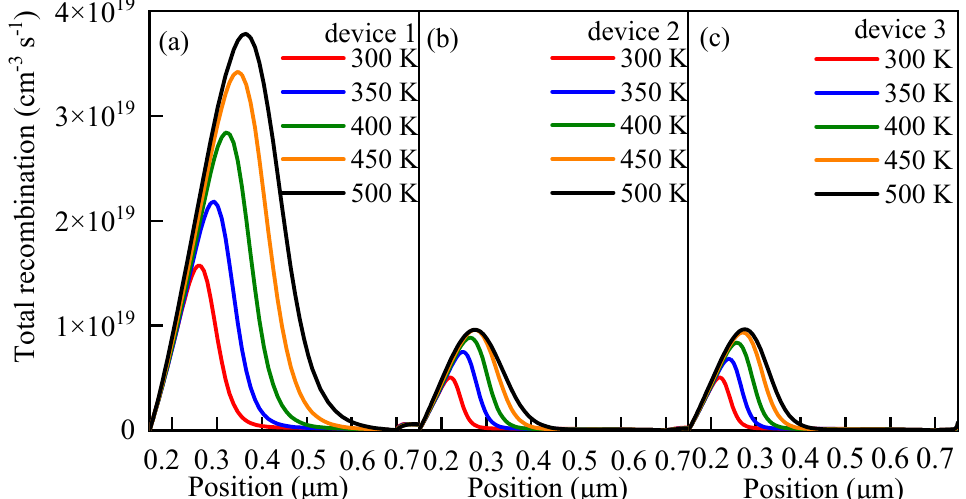
Figure 21. Effects of temperature on the carrier recombination: ( a ) carrier recombination of device 1 at different temperatures, ( b ) carrier recombination of device 2 at different temperatures, and ( c ) carrier recombination of device 3 at different temperatures.